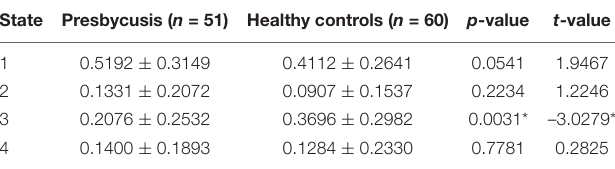
TABLE 4 | Two sample t -test of fraction time between the patients with presbycusis and the